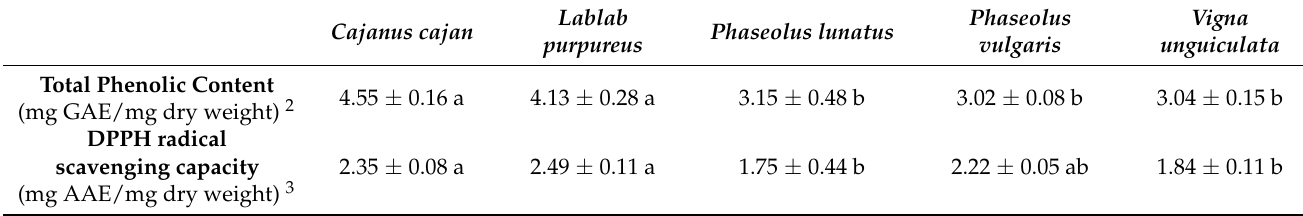
Table 2. Mean values, standard deviations and homogeneous groups 1 of the antioxidant capacities of the five most culti- vated and traded legumes of Cabo Verde. Table 3. Mean values (mg/kg wet weight), standard deviations and homogeneous groups 1 for the mineral contents in the beans of the five most cultivated and traded legume species of Cabo